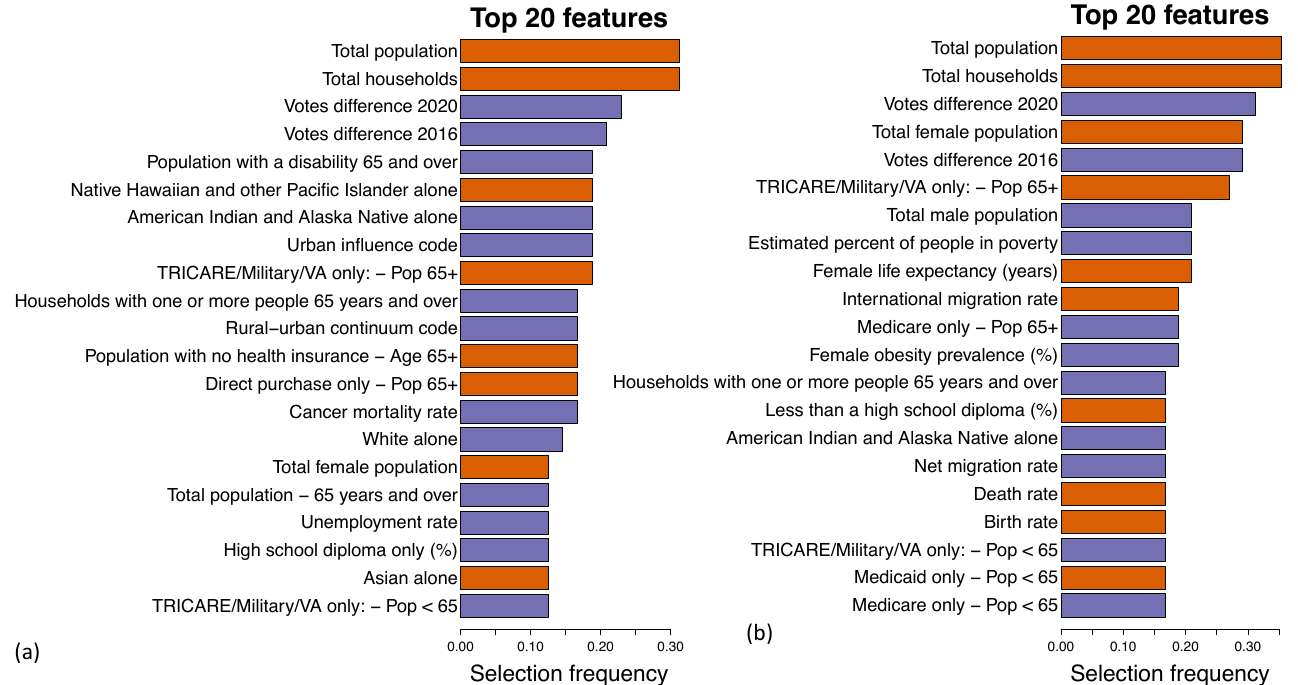
Figure A7. ( a , b ) The most predictive top 20 features selected overall by the algorithm for case and death count predictions from 11 September 2020 to 1 January 2021, respectively. Purple-colored features are negatively correlated with the case/death counts and the orange-colored features are positively correlated with the case/death counts,